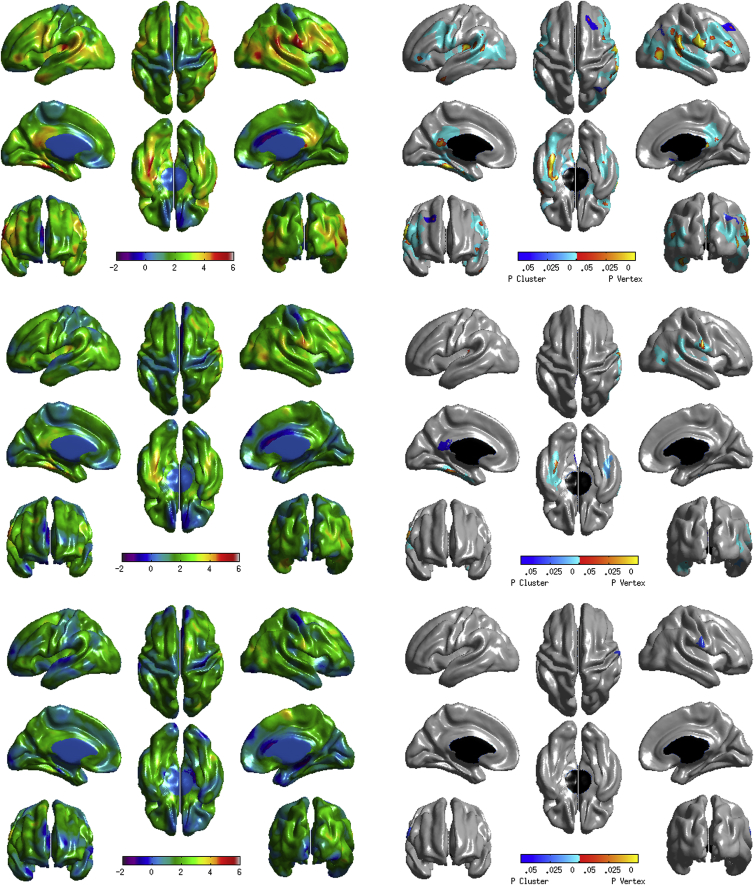
Associations (t-maps [left] and p-maps [right]) between cortical thickness and Trail Making B completion time corrected for age, education, sex and intracranial volume (Top), age, education, sex, intracranial volume and a latent processing speed factor including inspection time and simple reaction time only (Middle), and additionally corrected for a latent factor of processing speed including all five processing speed measures (Bottom). Cluster p-values show regions of connected vertices with p-values below .001 in clusters whose extent is significant at p < .05 (http://www.math.mcgill.ca.keith/surfstat), i.e., a collection of connected vertices with p < .001 that was unlikely to occur by chance. Vertex p-values show individual vertices where individual t scores are above the vertex-wise RFT critical t-value, i.e., statistically significant (pRFT < .05), which is derived via the expected Euler characteristic (EC ≈ critical p-value [.05]) and number of resolution elements (“resels”) in the t cortical map (Brett et al., 2004, Worsley et al., 1992).